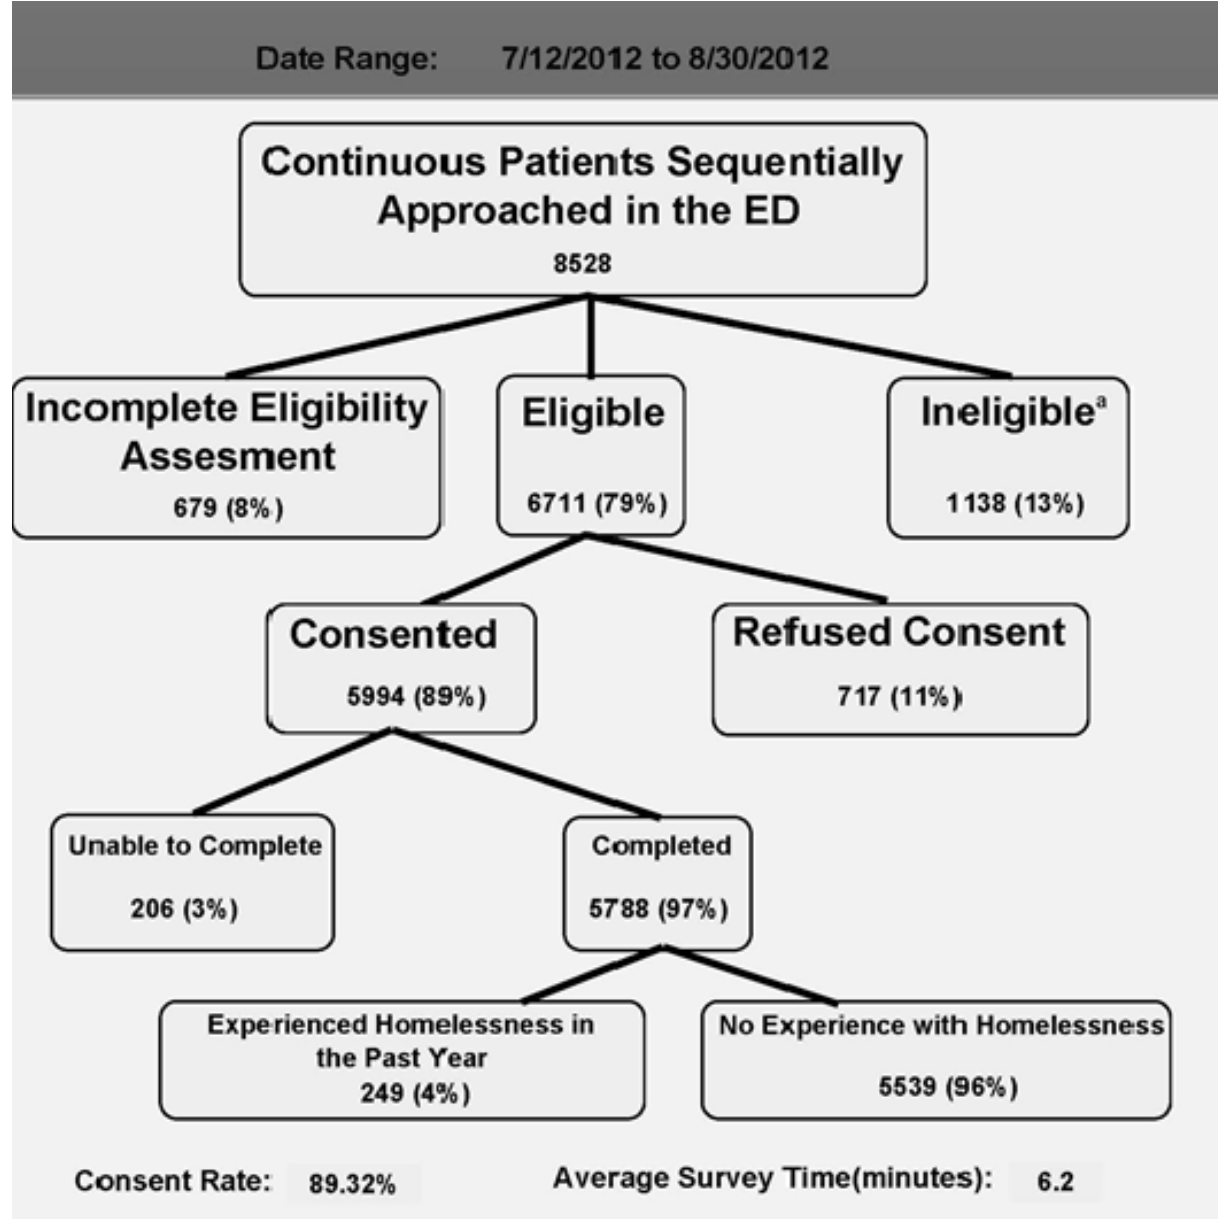
Figure 1. Patient flow